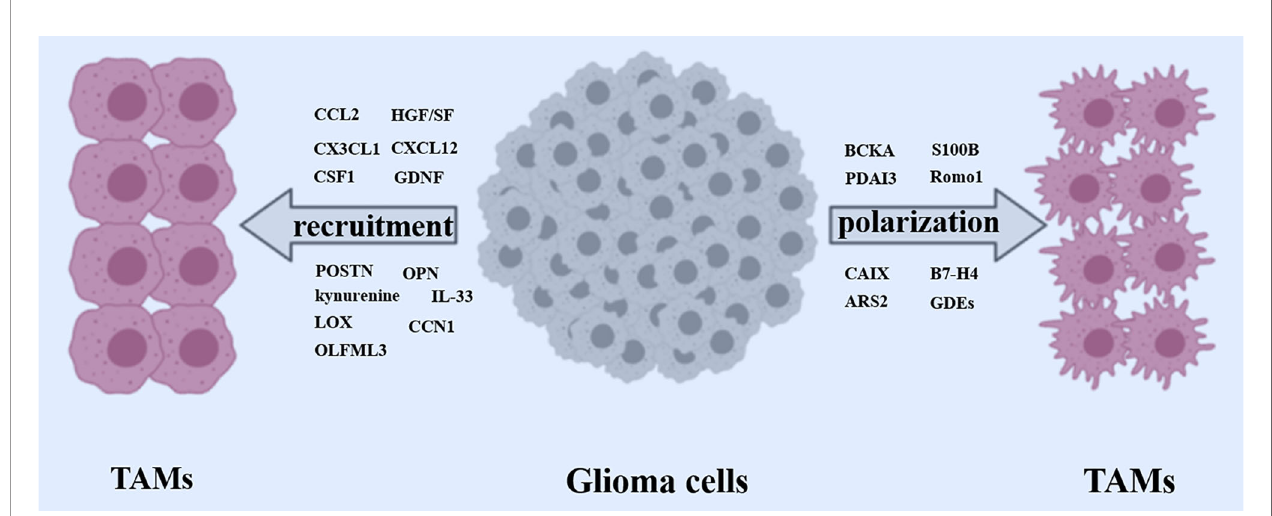
FIGURE 2 | Recruitment and polarization of TAMs. Glioma cells released a wide array of factors (CCL2, CX3CL1, CSF1, GDNF, HGF/SF, CXCL12, POSTN, OPN, Kynurenine, LOX, IL-33, CCN1) to recruit TAMs. Meanwhile, some crucial glioma cells-derived factors (BCKA, PDAI3, S100B, Romo1, CAIX, B7-H4, ARS2, GDEs) are involved in polarizing TAMs toward a pro-tumor